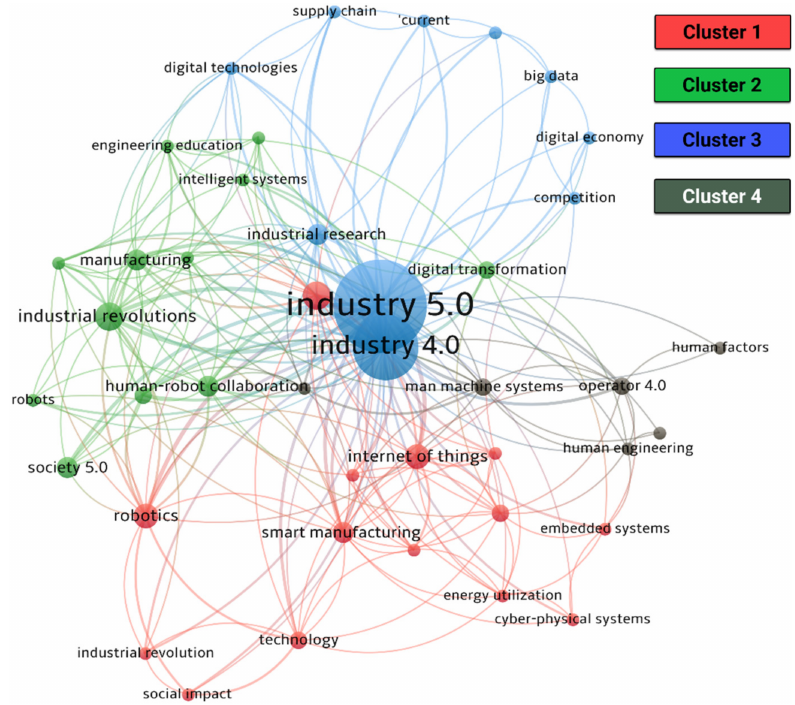
Figure 7. Keyword co-occurrence analysis of smart logistics in Industry